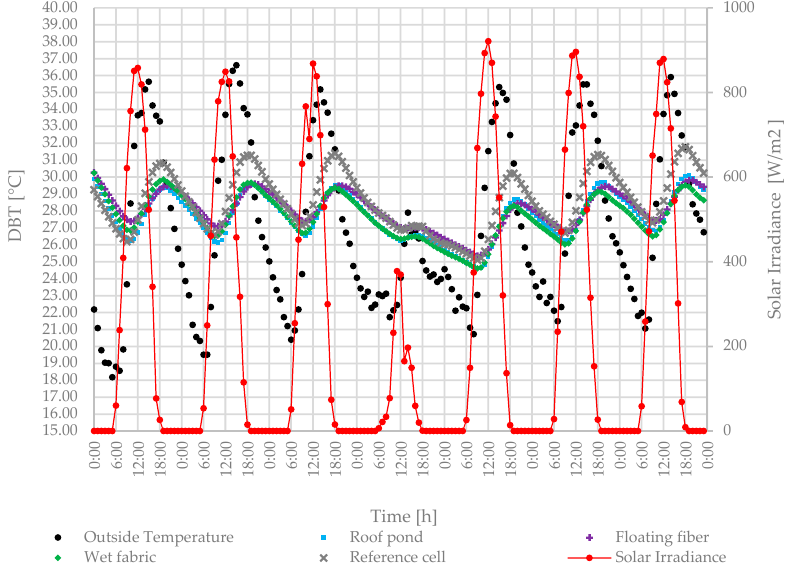
Figure 11. Comparison of the indoor air temperatures in the hot sub ‐ humid season. The maximum DBT values, RP, FF, and WF presented a decrement of 1.5 °C, 1.4 °C, and 1.7 °C in comparison with the RC, respectively, and 5.2 °C, 5.1 °C, and 5.3 °C, respec ‐ tively, taking the outside DBT as a reference. The general performance of the devices is consistent with the performance of the previous climate season. It can be observed that the differences between the devices are marginal but slightly better than the RP and WF over the FF (Figure 12). Figure 12. Box plot of the indoor air temperatures in the hot sub ‐ humid season. 3.3. Hot Humid Climatic Condition For the hot humid season, the RH swing was between 66% and 96%, considerably higher than the previous two climate types. During the experimental stage, there was a gap of six hours where all the equipment did not work during the first day. In addition, the pyranometer suffered a failure that resulted in missing the solar irradiation data for